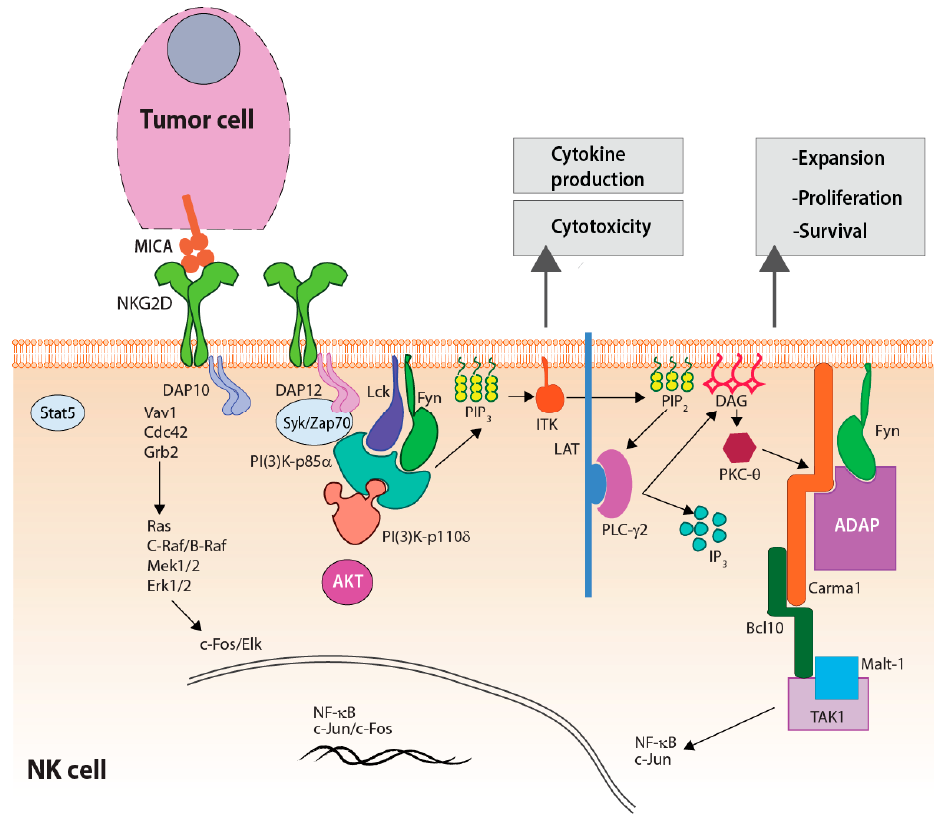
Figure 4. NK cells receive primary signaling through germline-encoded receptors. NKG2D engagement with MHC class I chain related-proteins A (MICA) induces activation of either DAP10 or DAP12 signaling. DAP10 signaling leads to tyrosine phosphorylation of the YINM motif and stimulation of Vav1/Cdc42/Grb2/PI(3)K signaling cascade and nuclear translocation of c-Fos/Elk transcription factors. DAP12 signaling leads to phosphorylation of the ITAM, which allows for Syk/Zap70 signaling cascade to proceed (cytotoxicity and cytokine production). This ‘primary signal’ activates NK cells and initiates the production of large amounts of pro ‐ inflammatory cytokines and direct cytolytic clearance of the virus ‐ infected cells [63,64]. Murine strains which lack Ly49H ‐ expressing NK cells are susceptible to a more severe MCMV infection [65]. NKG2C recognizing the HLA ‐ E loaded with an HCMV viral peptide is presumably the human counterpart of the m157 ‐ Ly49H axis [66,67]. A similar immunosurveillance mechanism has been found in influenza infections where the virus ‐ encoded hemagglutinin is recognized by another NK cell activating receptor, NCR1 [68]. Besides direct control of viral infections, NK cells also shape the adaptive immune re ‐ sponse [69]. The pro ‐ inflammatory cytokines, especially IFN ‐γ produced by NK cells, reg ‐ ulate the differentiation of Th1 cells, a critical T cell subset that controls viral infections [70]. 2.3. Fc Receptors and NK Cell Activation ADCC represents a classical example of cell ‐ cell collaboration between NK and B cells. ADCC is an Fc ‐ dependent effector function of IgG that plays an essential role in anti ‐ viral and anti ‐ tumor immunity. Immunoglobulins (Igs) are the most efficient soluble fac ‐ tors of the humoral immunity. In addition, Igs also facilitate cell ‐ mediated cytotoxicity